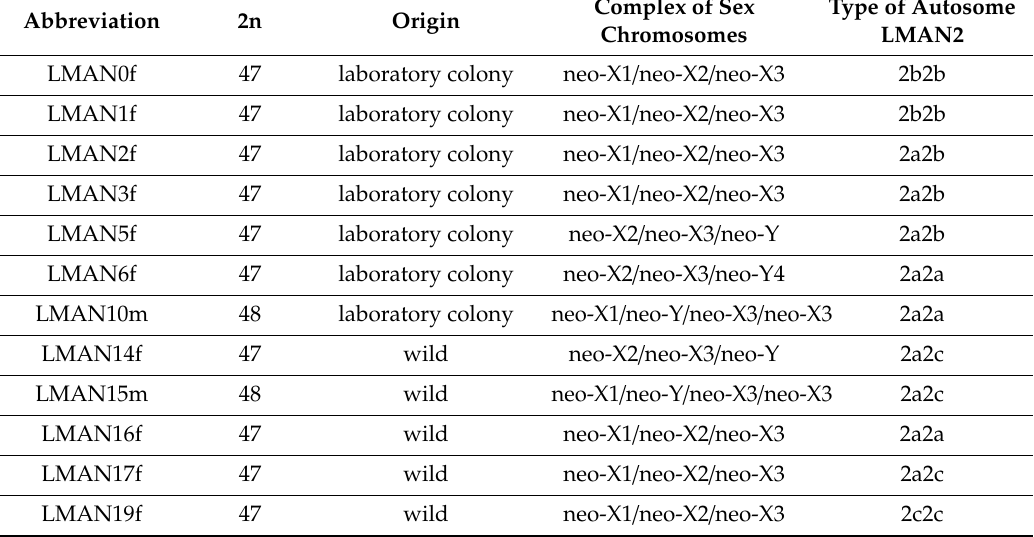
Table 2. The list of investigated individuals of Lasiopodomys mandarinus vinogradovi with abbreviated names, diploid numbers (2n), origin, systems of sex chromosomes, and types of autosome LMAN2; f, female; m, male; 2a, the acrocentric with the order of syntenic blocks MAG1 / 5; 2b, the acrocentric with the order of syntenic blocks MAG1 / 5 / 1 / 5 / 1 / 5; 2c, the submetacentric with the order of syntenic blocks MAG5 / 1 / 5 / 1. See comments in the